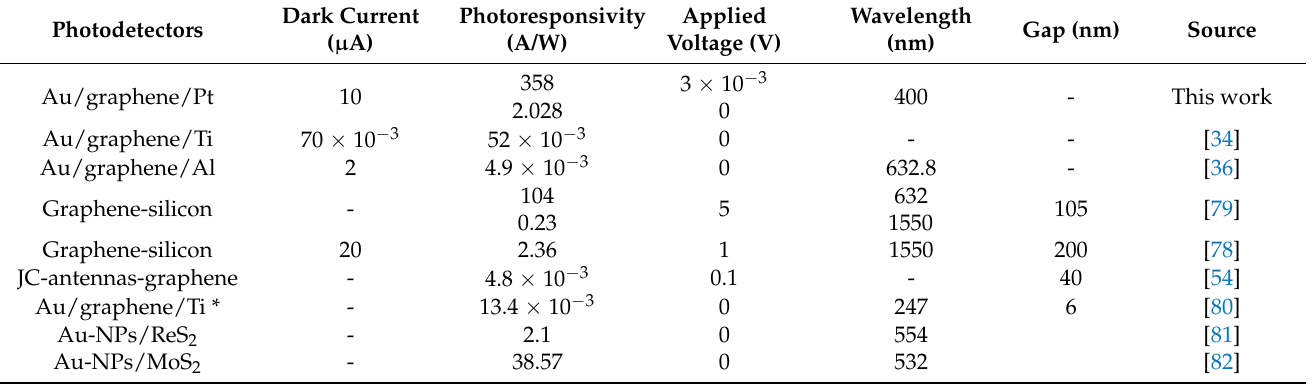
Table 1. Comparison of the obtained photodetector’s parameters with typical graphene